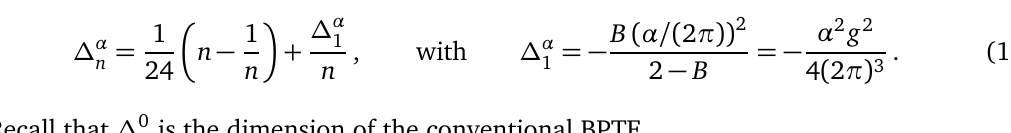
Table 2: The ∆ -sum rule in the two-particle approximation (SR) compared with the exact conformal dimension of the exponential CFT in the shG model (61) for B . For comparison, the tables include α = 0, that is the standard BPTF and n = 1, α (cid:54) = 0 corresponding to the exponential field in shG. In all cases the agreement is very